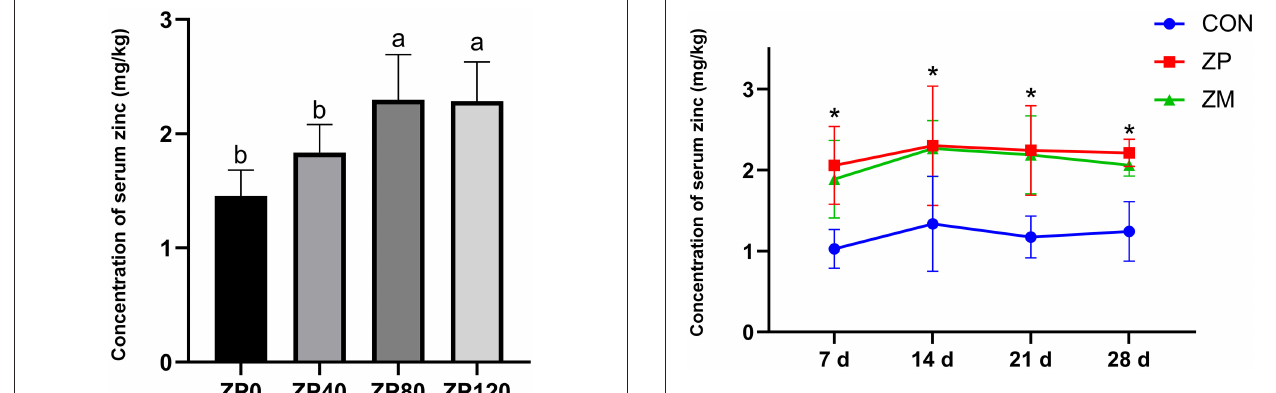
FIGURE 2 | The concentration of serum zinc in dairy cows supplemented with organic zinc sources during the first month of life (Experiment 2). *Mean values in the same row with different superscripts are significantly different ( P < 0.01). CON, no organic zinc supplementation ( n = 12); ZP group, provided 522.88mg zinc proteinate (equivalent to 80mg zinc/day; n = 12); ZM group, provided 467.88mg ZM per day (equivalent to 80mg zinc/day; n = 12).